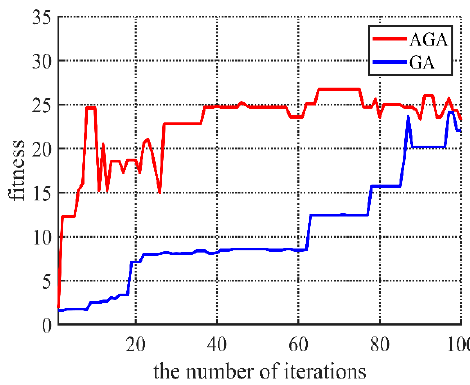
Figure 10. Acquisition frequency vs. error value’s mean value.